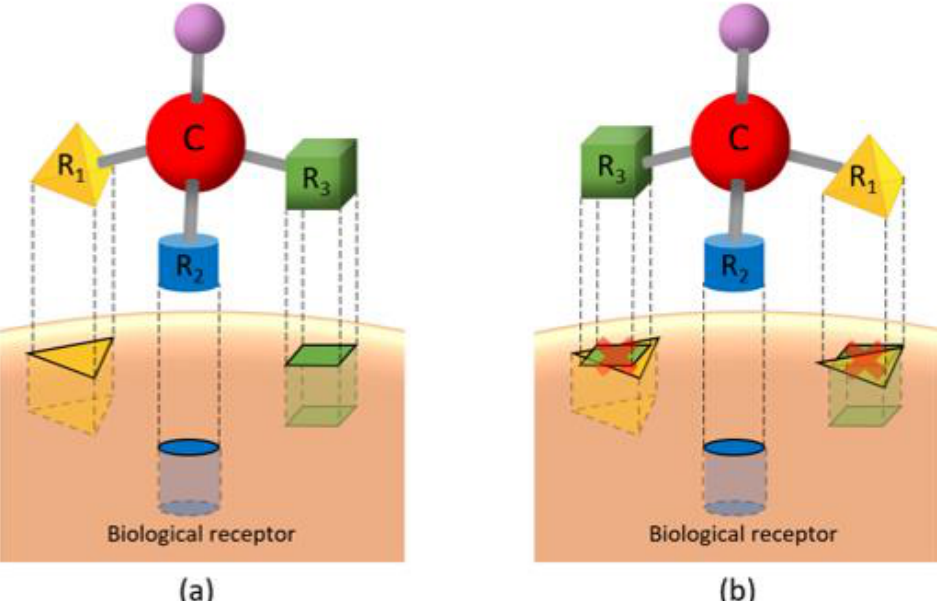
Figure 7. Perfect ( a ) and failed ( b ) connection between enantiomers and biological receptor.